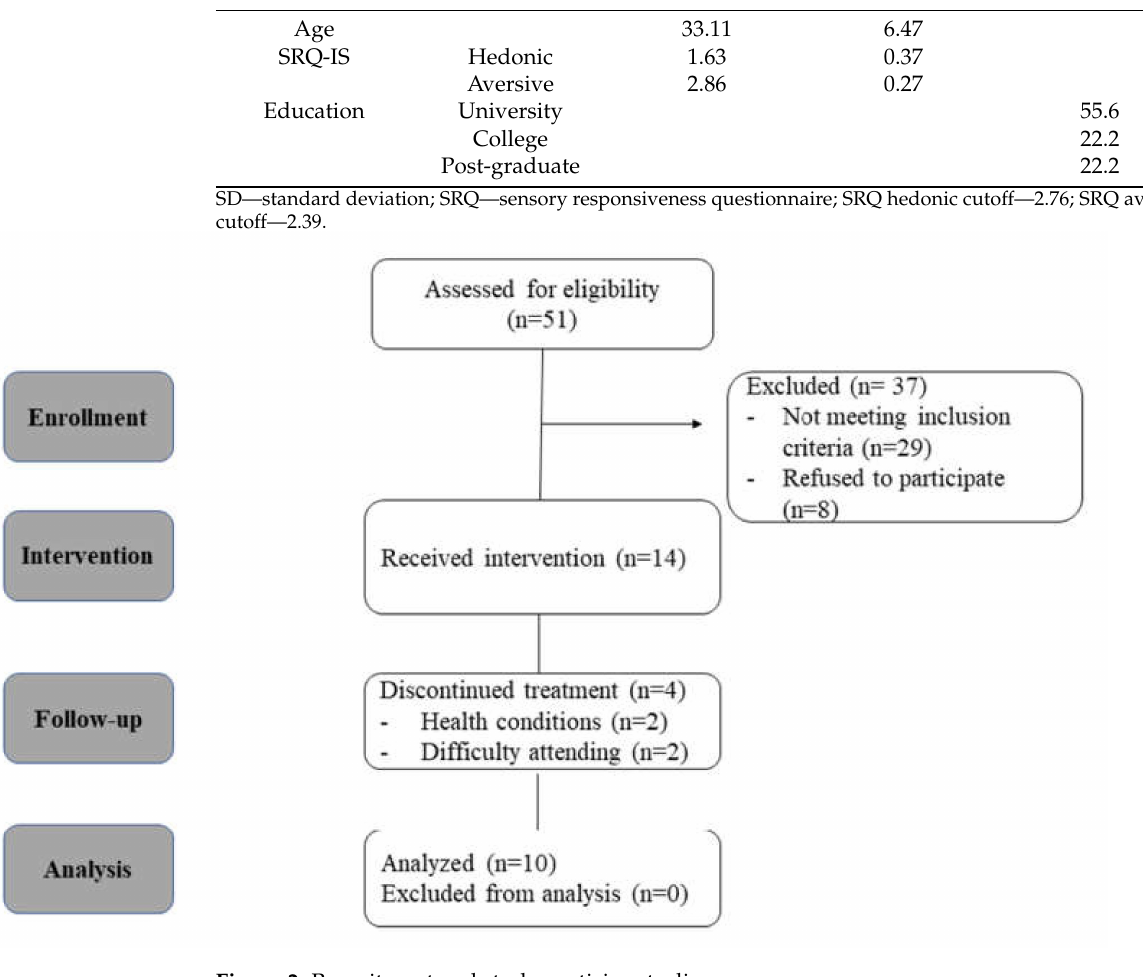
Figure 2. Recruitment and study participants